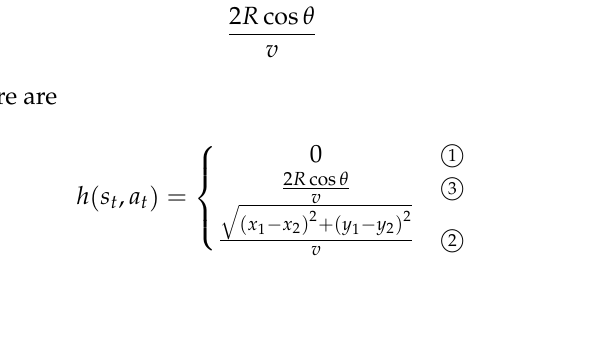
Figure 5. Campaign revenue model (for users not in the service).